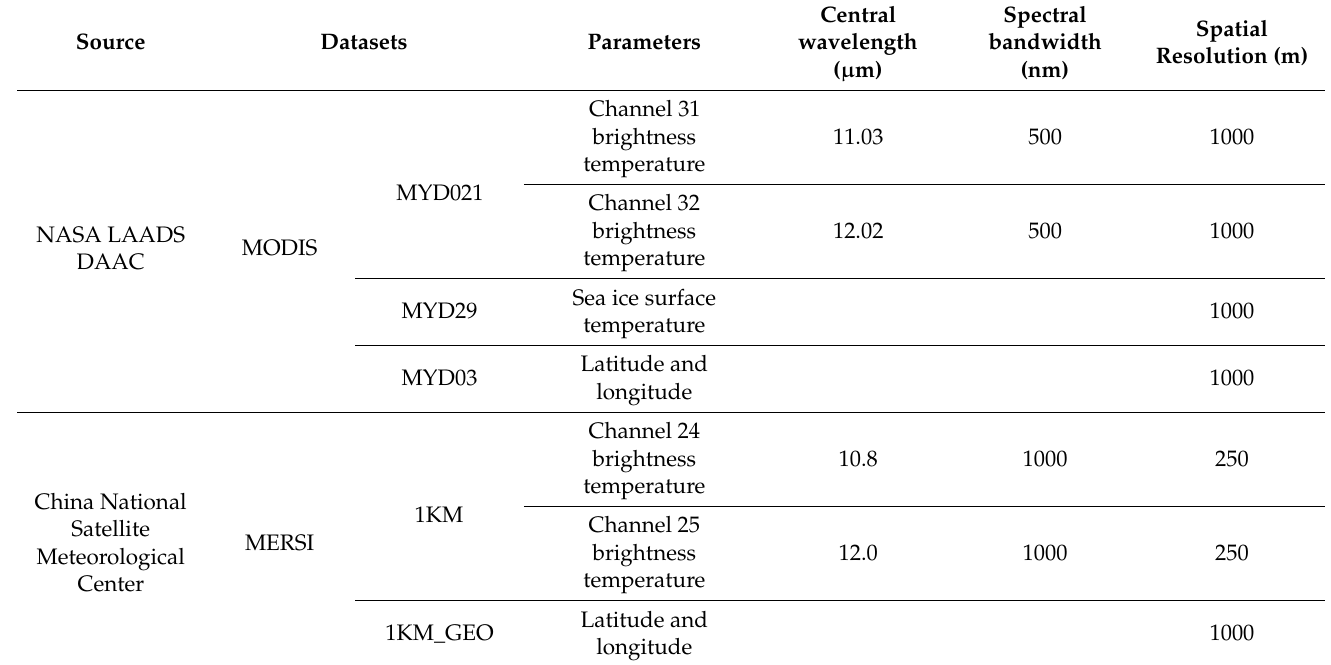
Table 1. Sources and resolutions of the data